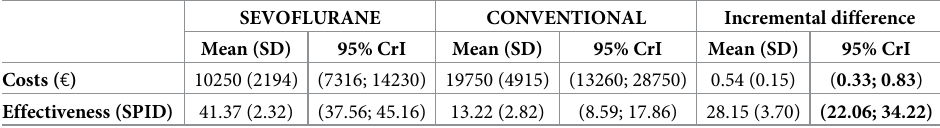
Table 4. Statistical summary of costs and effectiveness (100,000 simulations MCMC).